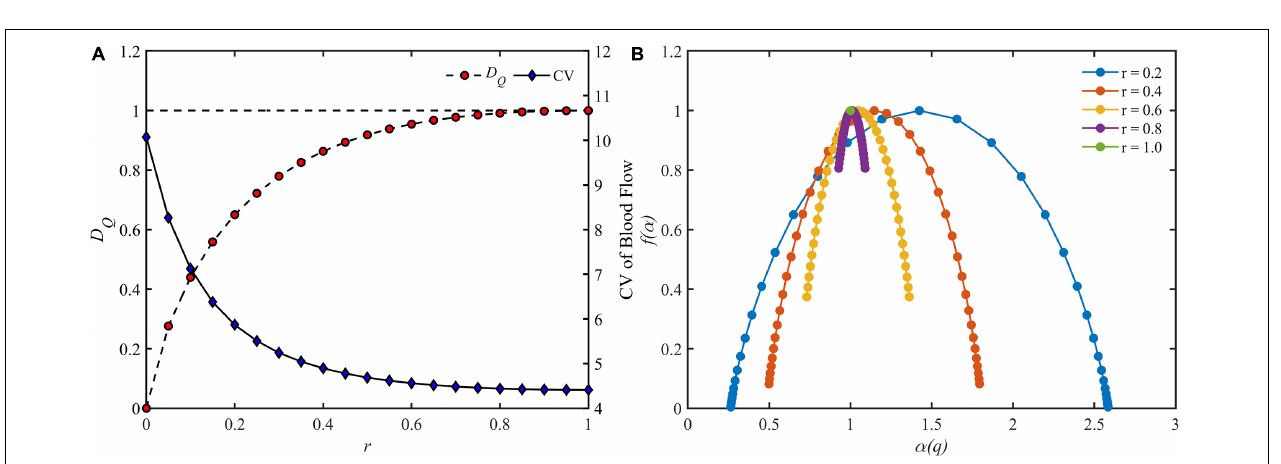
FIGURE 4 | (A) The blood flow distribution in the arterial tree under normal state. (B) The blood flow distribution in the arterial tree under ischemic state. (C) The multifractal spectrum of the blood flow distribution under normal state. (D) The multifractal spectrum of the blood flow distribution under ischemic state.